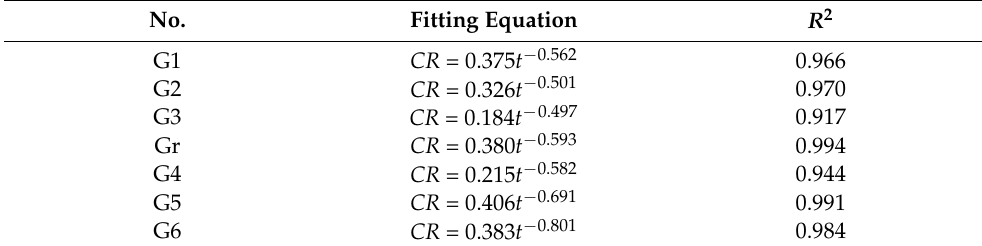
Figure 8. The relationship between corrosion rate and time in laboratory accelerated corrosion test. Table 6. The fitting equations between corrosion rate and test time for laboratory accelerated corrosion results.